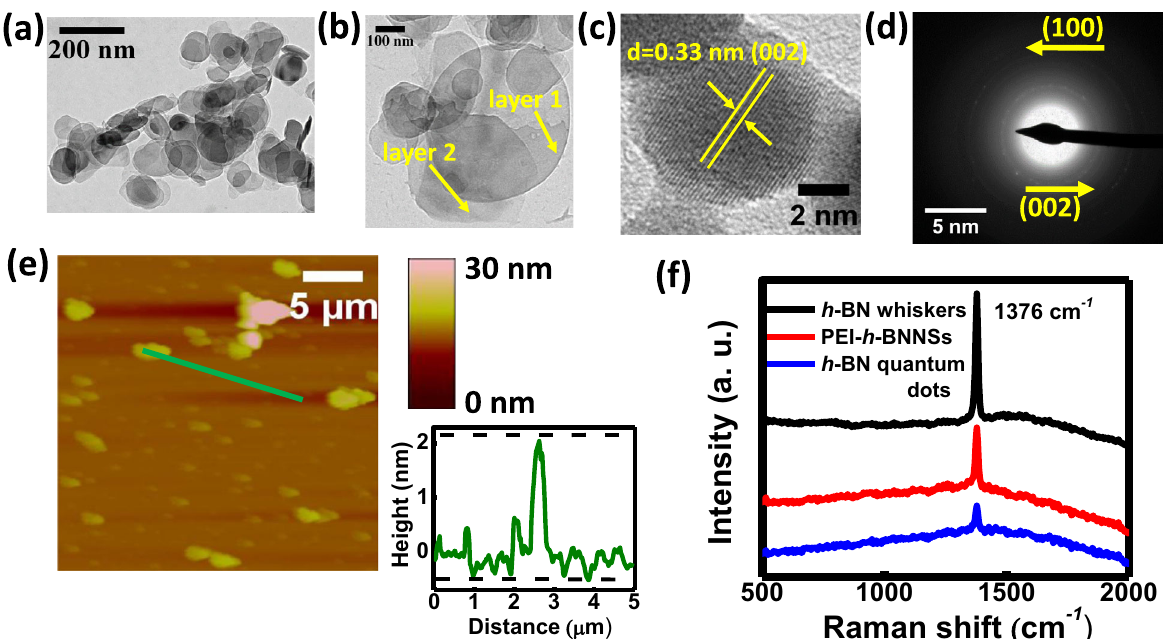
Fig. 2 Morphological and spectroscopic studies. Characterization of the PEI- h -BNNSs: a , b Low-magni fi cation of TEM images, c high- resolution of TEM image, d SAED pattern, e AFM image and height pro fi le (green line), and f Raman spectra (red line). The black and blue lines are ( f ) correspond to the Raman spectra of h -BN whiskers and h -BN quantum dots,